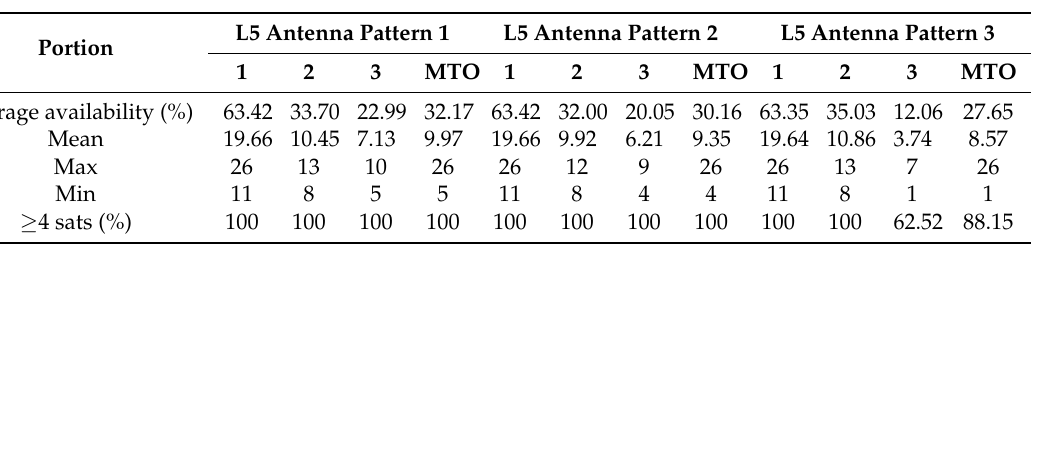
Table 6. Statistics for the number of available